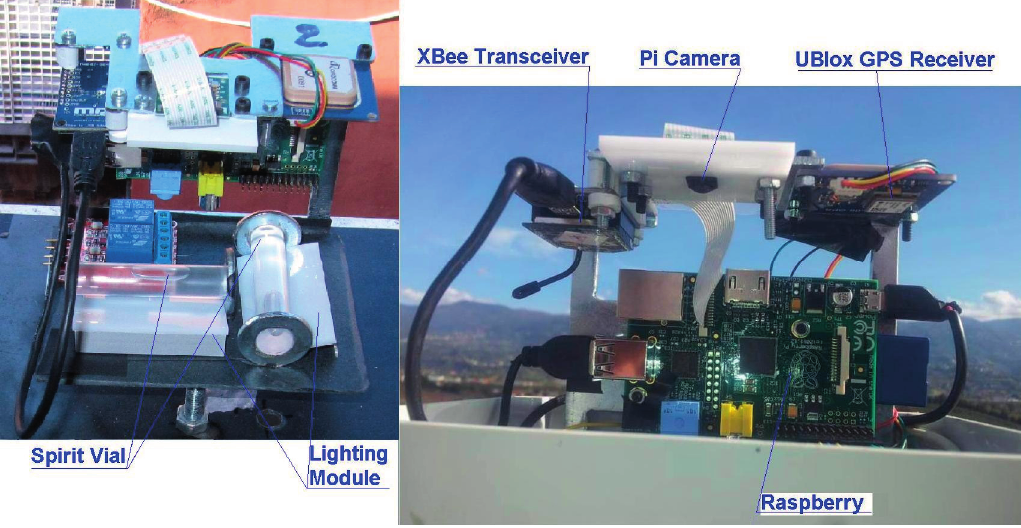
Figure 1. The main components of the sensor